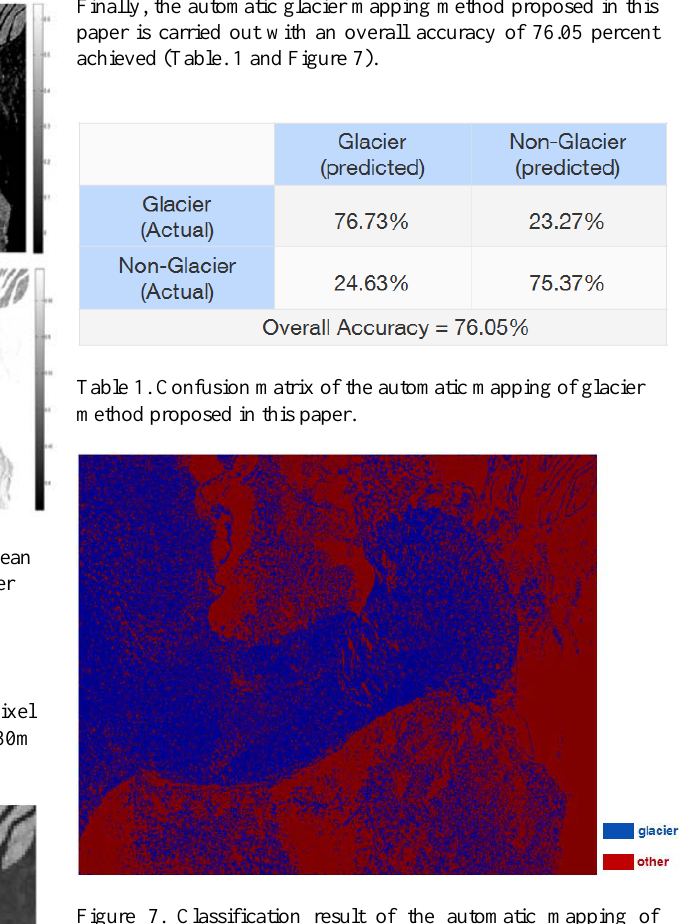
Figure 7. Classification result of the automatic mapping of glacier method proposed in this paper. Blue colour: glacier area; Red colour: non-glacier area.